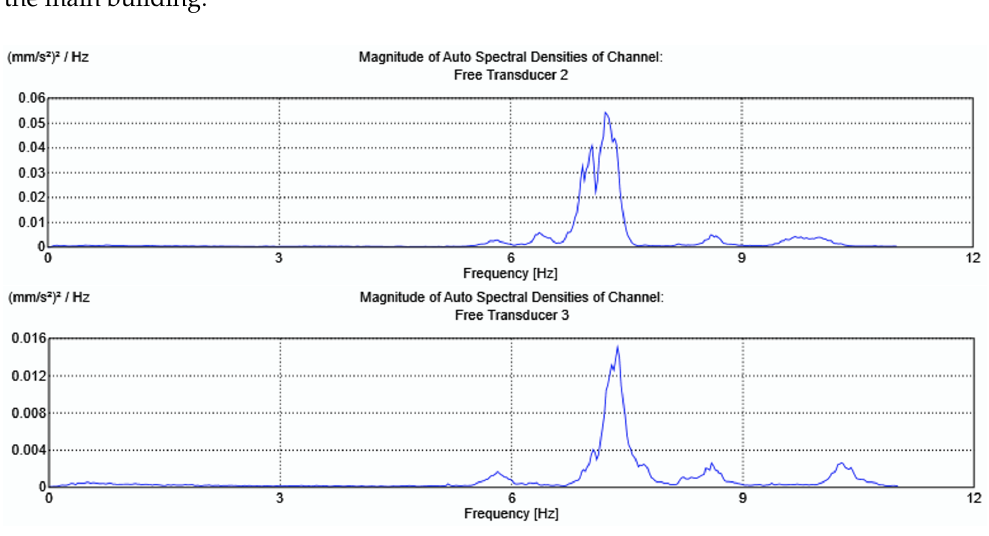
Figure 10. Magnitude of auto spectral density for accelerometer 2 (central wing, garret) and 3 (main building, second